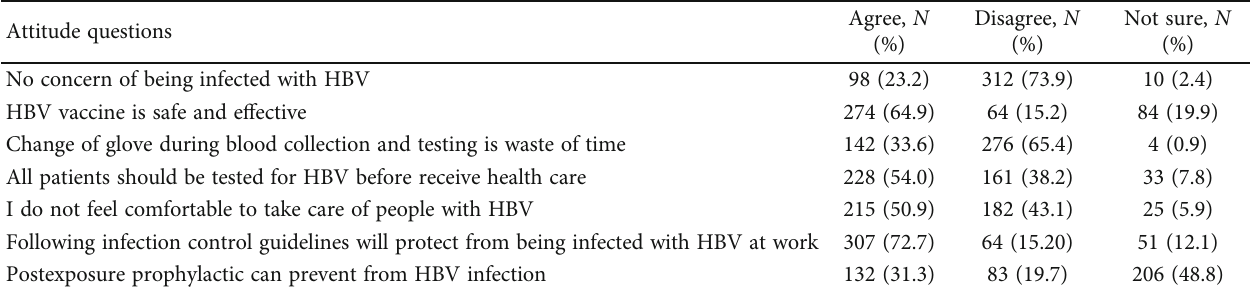
Table 4: Attitude-related questions about HBV early detection, transmission, and prevention.